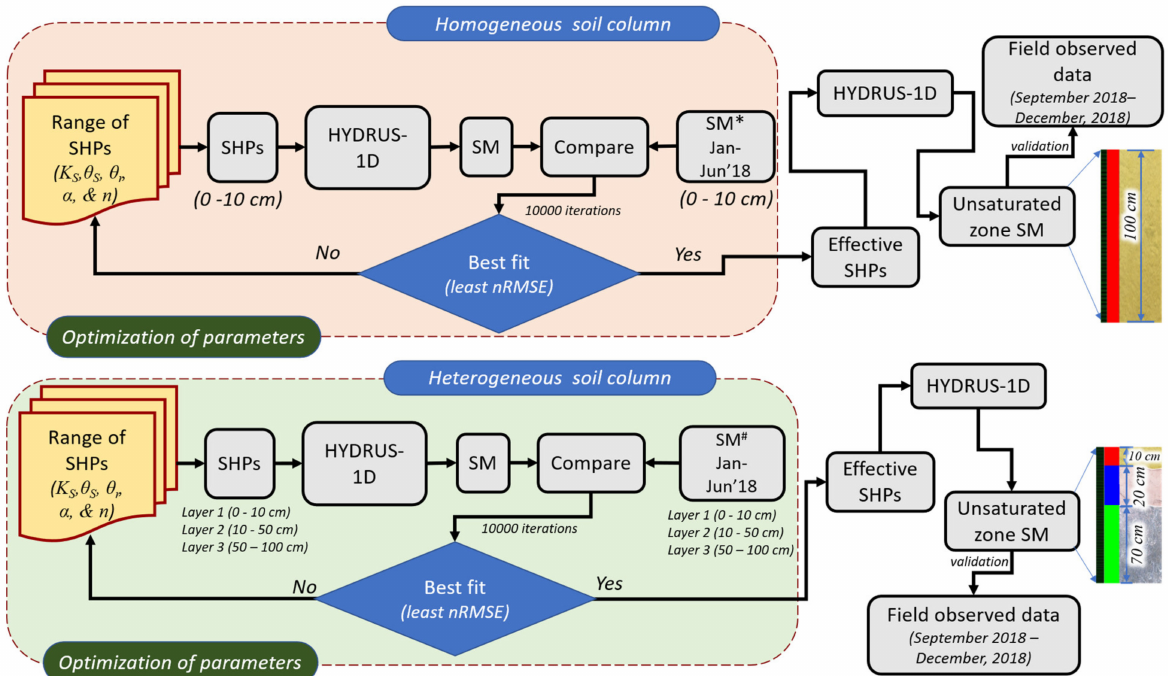
Figure 6. The methodology adopted for optimization of SHPs for the homogeneous and hetero- geneous soil column for calibration and validation period. SM indicates the soil moisture from HYDRUS-1D. SM* indicates the soil moisture datasets such as HDS in-situ data ( I-b treatment) , AMSR-2 at 25 km 2 ( I-c treatment), and Downscaled soil moisture at 1 km 2 ( I-d treatment) with which optimization is achieved in homogeneous soil column. SM # indicates the soil moisture dataset from HDS in-situ soil moisture ( II-b